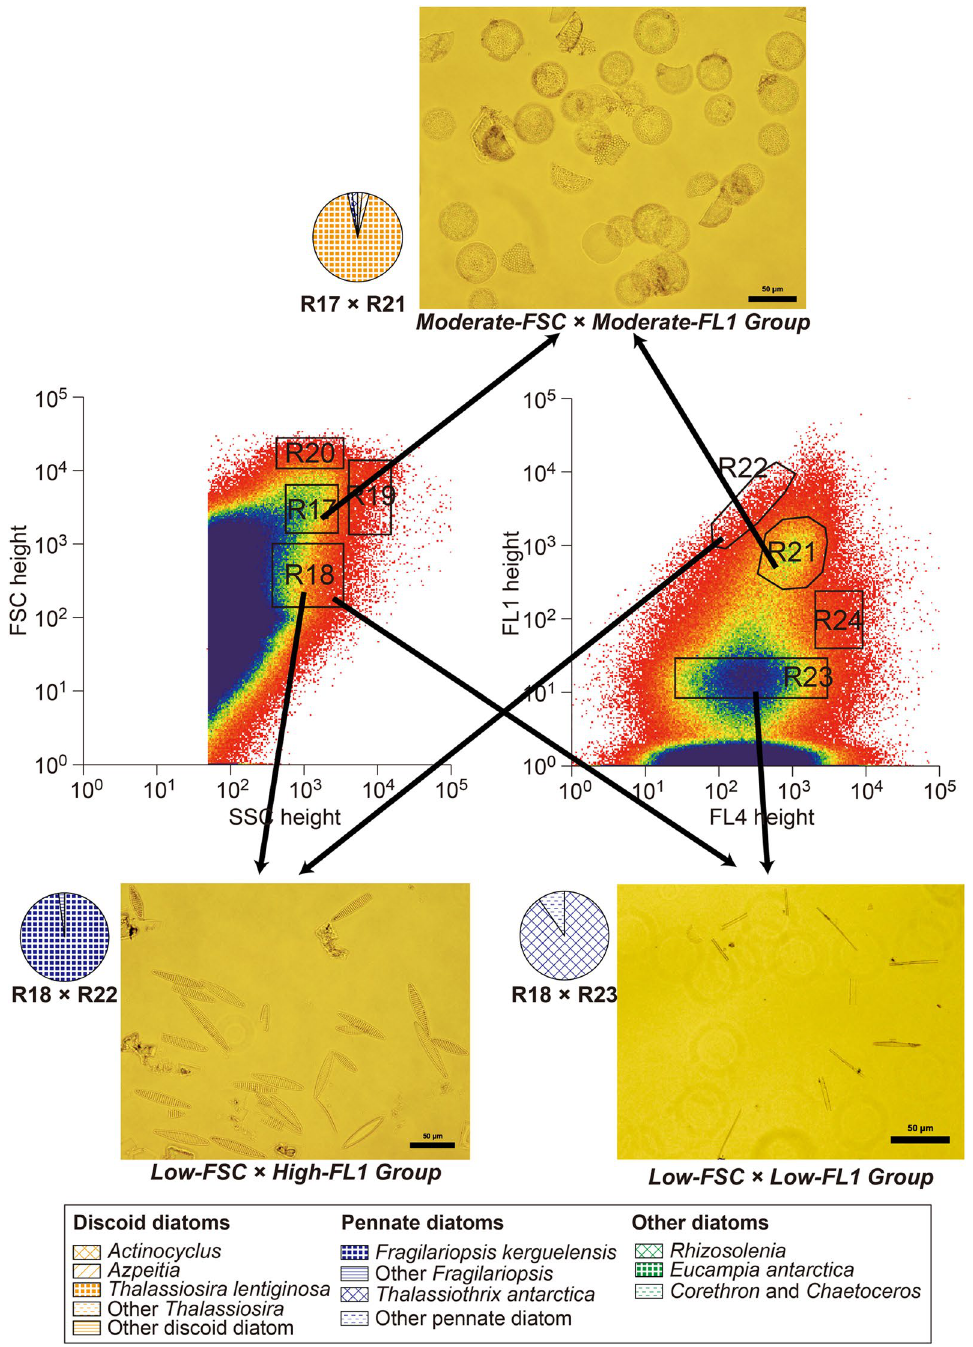
Fig. 7 Flow cytograms of sample 382-U1538A-5-6, 24–25 cm (last interglacial) and pie charts/photomicrographs showing the diatom assemblages obtained by sorting of the following composite regions: Regions 17 and 21 (discoid-diatom-rich); Regions 18 and 22 ( Fragilariopsis -rich); and Regions 18 and 23 ( Thalassiothrix -rich). The crystalline materials in the micrographs are NaCl crystals in the sheath